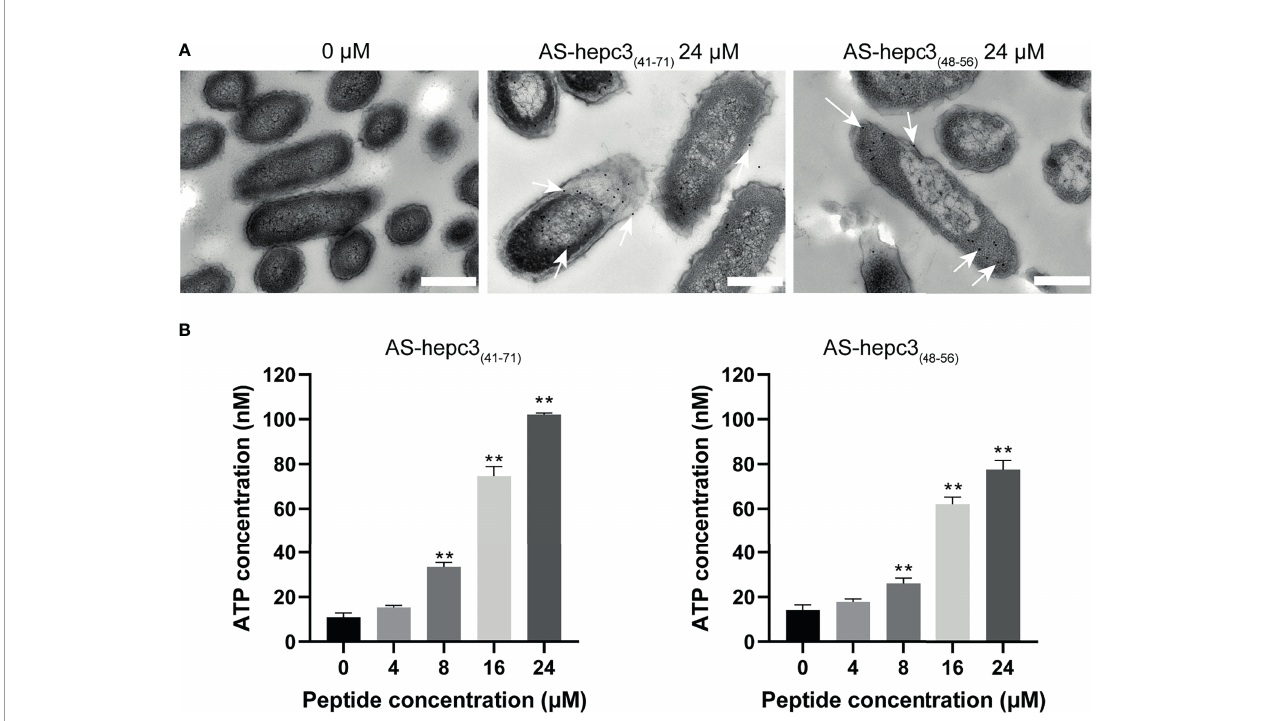
FIGURE 4 | The location and effect of AS-hepc3 (41-71) and AS-hepc3 (48-56) on PAO1. (A) The location of AS-hepc3 (41-71) and AS-hepc3 (48-56) on PAO1. Scale bars, 500 nm. (B) The effect of AS-hepc3 (41-71) and AS-hepc3 (48-56) on the release of ATP at different concentrations. Error bars represent the standard deviation from the mean (n = 3), signi fi cantly different (** P < 0.01) as compared to control (0 m M), calculated using one-way